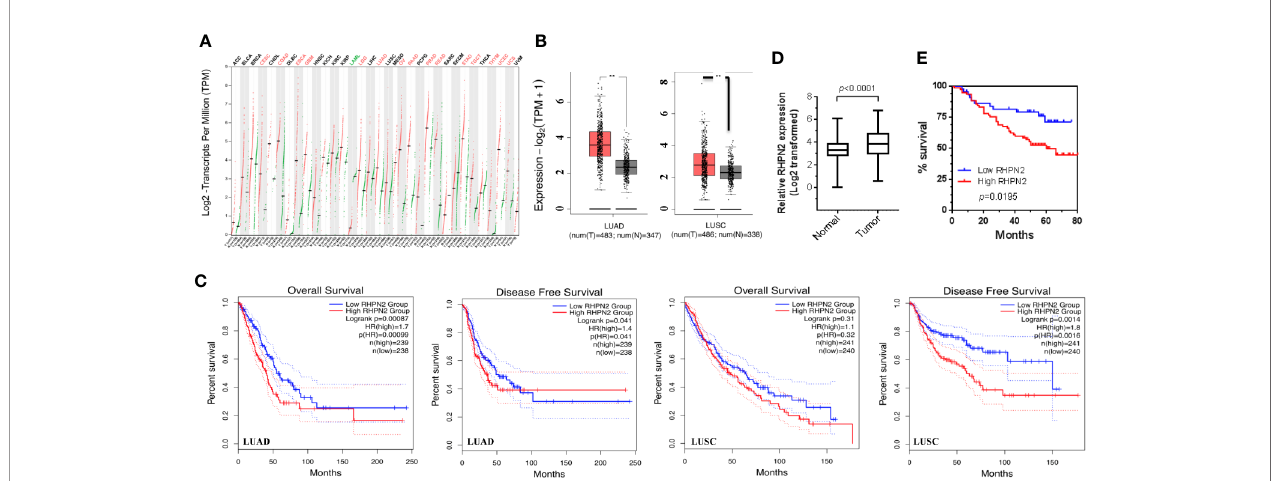
FIGURE 1 | Overexpression of RHPN2 is associated with worse clinical outcome of patients with lung adenocarcinoma. (A) The log 2 -transformed expression of RHPN2 in primary tumors and normal tissues of the patients with lung cancer and other cancer types from TCGA. (B) The log2 transformed expression of RHPN2 in tumors and normal tissues of lung adenocarcinoma (LUAD) and LUSC from TCGA. (C) The association of RHPN2 levels with overall survival and disease-free survival in LUAD and LUSC from TCGA. (D) The relative expression of RHPN2 in tumors and matched normal tissues from our institute. (E) Overall survival curves for the LUAD patients from our institute with different levels of RHPN2. ** p < 0.01 compared with control